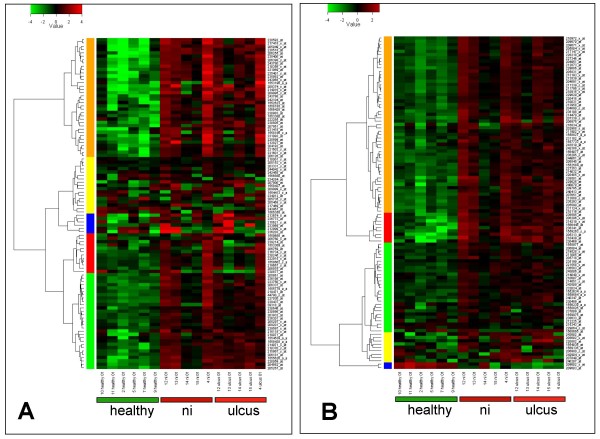
Heatmap visualization of the top 100 B- and T-cell markers. Using a biomarker search with Genevestigator [33] we identified the top 100 probe sets that were specific for "B-lymphocytes" (A) and "T-lymphocytes" (B), respectively, and visualized them as a heatmap. For each probe set the heatmap shows the log2-ratio against the average of our entire data set. For both the B- and T-lymphocytes, a large proportion of the probe sets was upregulated in "ni" and "ulcus" as compared to the healthy tissue. Additional file 6 (Blympho-top100 cluster) and Additional file 7 (Tlympho-top100 cluster) list the top 100 probe sets and their corresponding gene names. Ulcer tissue (ulcus); non-ulcer tissue in patients with Hunner's ulcers (ni).